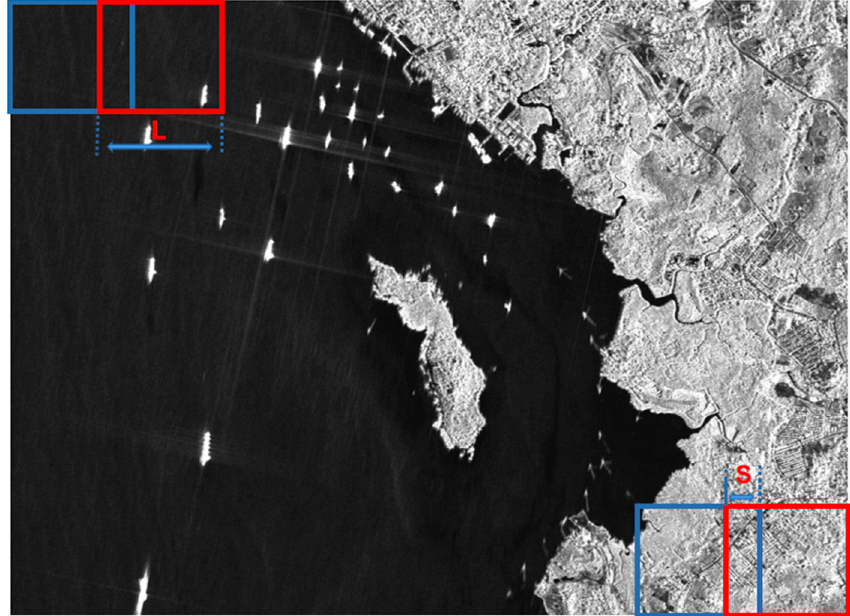
Figure 5. Schematic diagram of sliding window partition method. Blue and red are adjacent sub- blocks, L is the length and width of sub-blocks, and S is the degree of overlap between